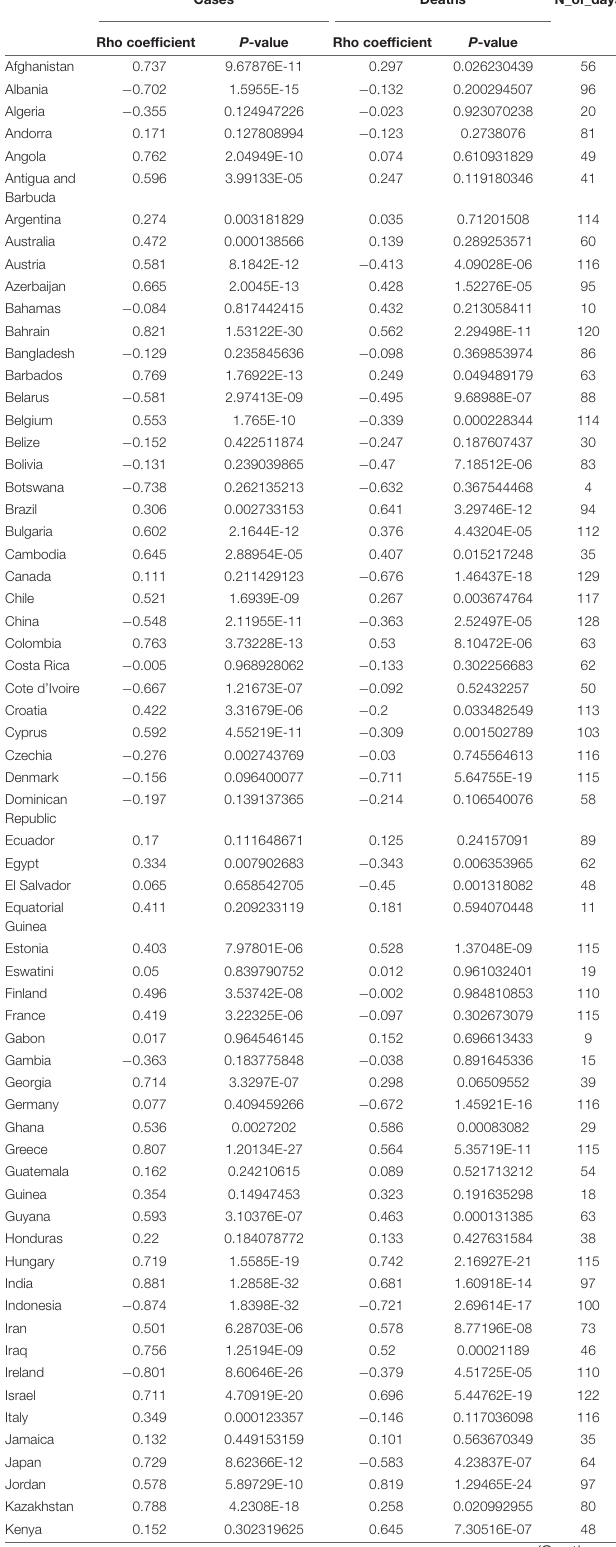
TABLE 1 | Correlation between the numbers of vaccines against the number of new cases and new deaths in the country have started the